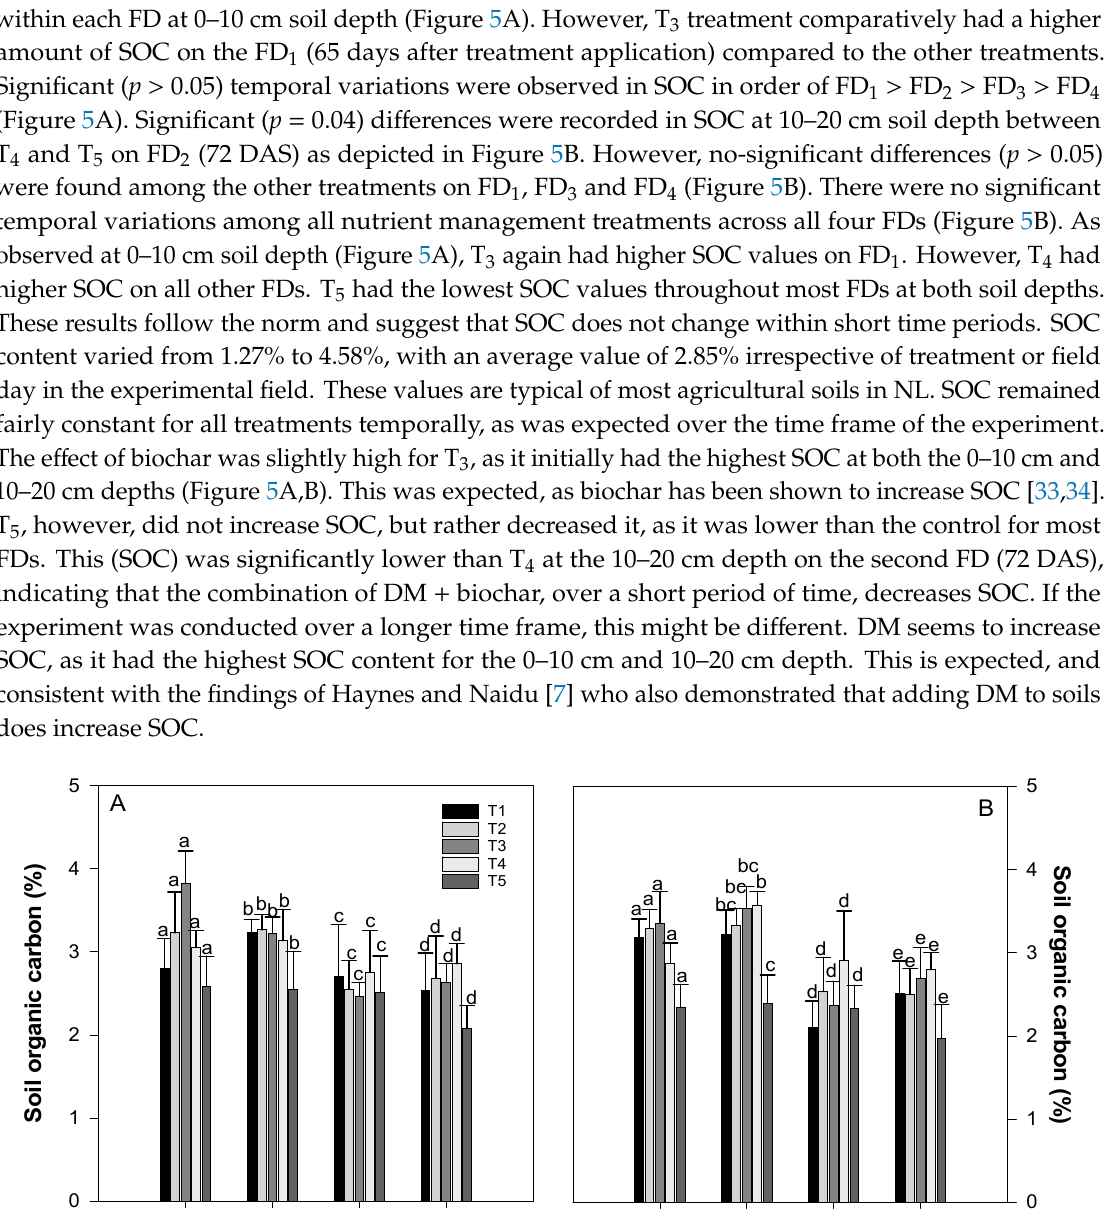
Figure 4. Effects of different soil amendments on temporal variations of soil pH at 0–10 cm ( A ) and 10–20 cm ( B ) sowing depth in podzolic soils under various nutrient management practices. Each vertical bar represents mean whereas bar errors show ± standard error for three replications. Lettering is independent of each other.